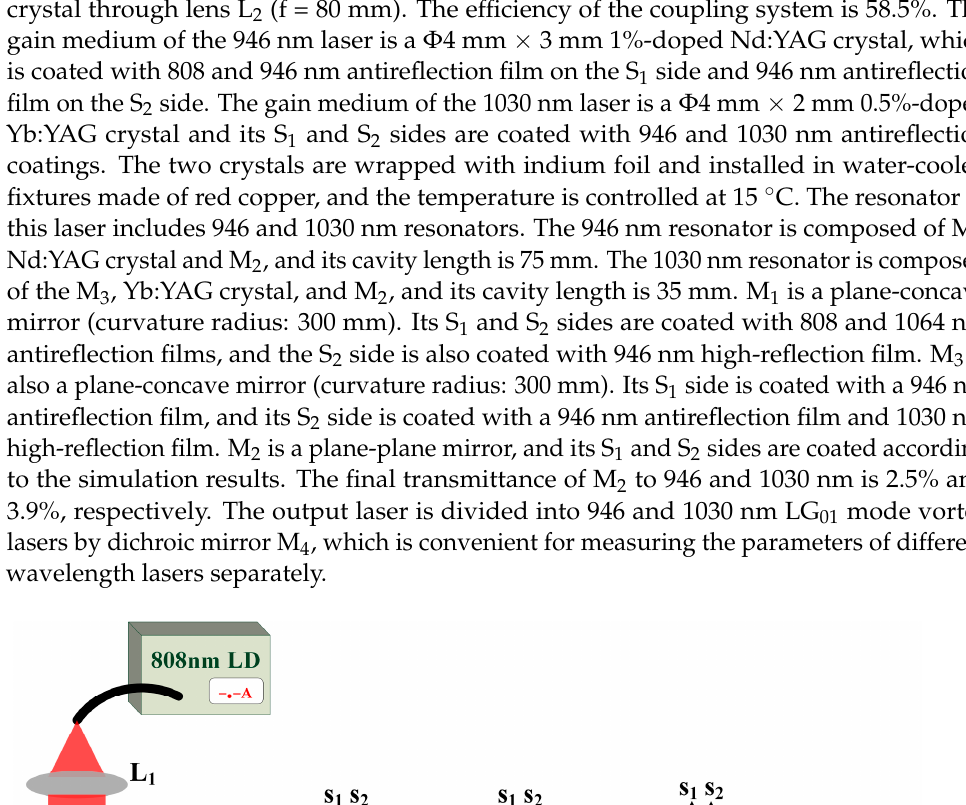
Figure 6. The spectrogram of the dual-wavelength laser. Vortex lasers with opposite handedness have the same threshold pump power, so the handedness of vortex lasers directly generated without pre-regulation is easy to change randomly. In order to reduce the insertion loss caused by additional optical ele- ments, a stable handedness of the 946 nm LG 01 mode vortex laser has been achieved by adjusting the transverse position of the Nd:YAG crystal [39]. A mode converter composed of cylindrical lenses converts the generated vortex laser into a Hermite–Gaussian (HG) laser. The vortex laser’s topological charge and handedness change are determined by the number of node lines and the direction of the long axis of the HG laser. The 946 nm vortex laser is adjusted to a direction parallel to the optical axis by a reflector to facilitate the measurement. The measurement diagram and results are shown in Figure 7. By carefully adjusting the lateral position or pitch angle of the laser crystals, the long-axis of the 946 and 1030 nm HG 01 mode lasers have the same handedness over the whole pump range.